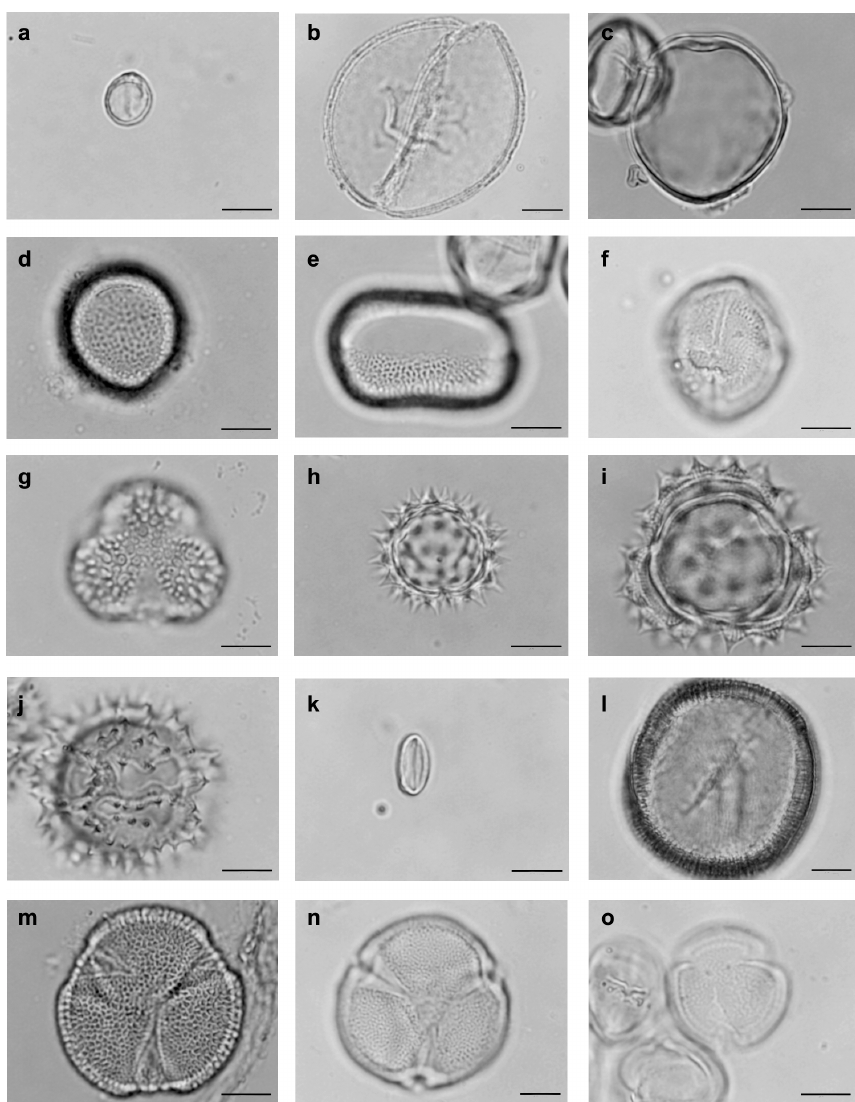
Figure 1. Pollen types from the bodies of floral visiting bees of Solanum dydimum at the Araucarias Municipal Park in Guarapuava, Paraná state, Brazil. ( a ) Angiosperms, Magnoliids. Piperaceae, Piper. ( b – e ) Angiosperms, Monocotyledons. ( b ) Arecaceae, Butia . ( c ) Poaceae. ( d ) Typhaceae, Typha . ( e ) Monocotyledon type. ( f – o ) Angiosperms. Eudicotyledons. ( f ) Anacardiaceae, Schinus . ( g ) Aquifoliaceae, Ilex . ( h ) Asteraceae, Baccharis . ( i ) Asteraceae, Stenachenium . ( j ) Asteraceae, Vernonia . ( k ) Begoniaceae, Begonia . ( l ) Convolvulaceae, Jacquemontia . ( m ) Dilleniaceae, Davilla . ( n ) Erythroxylaceae, Erythroxylum . ( o ) Euphorbiaceae, Sebastiania . (bar = 10 µm).